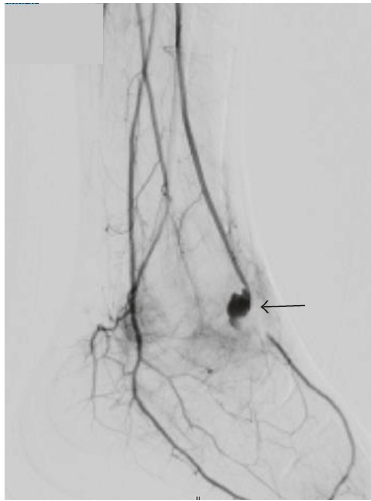
Figure 7: Angiographic image showing a pseudoaneurysm origi- nating from the anterior tibial artery and passing on the anterior side of the ankle joint. Predominantly anterograde filling from the anterior tibial artery is seen (arrow). Flow from the posterior tibial artery and the plantar collateral was also detected. The dorsalis pedis artery is filled by a plantar